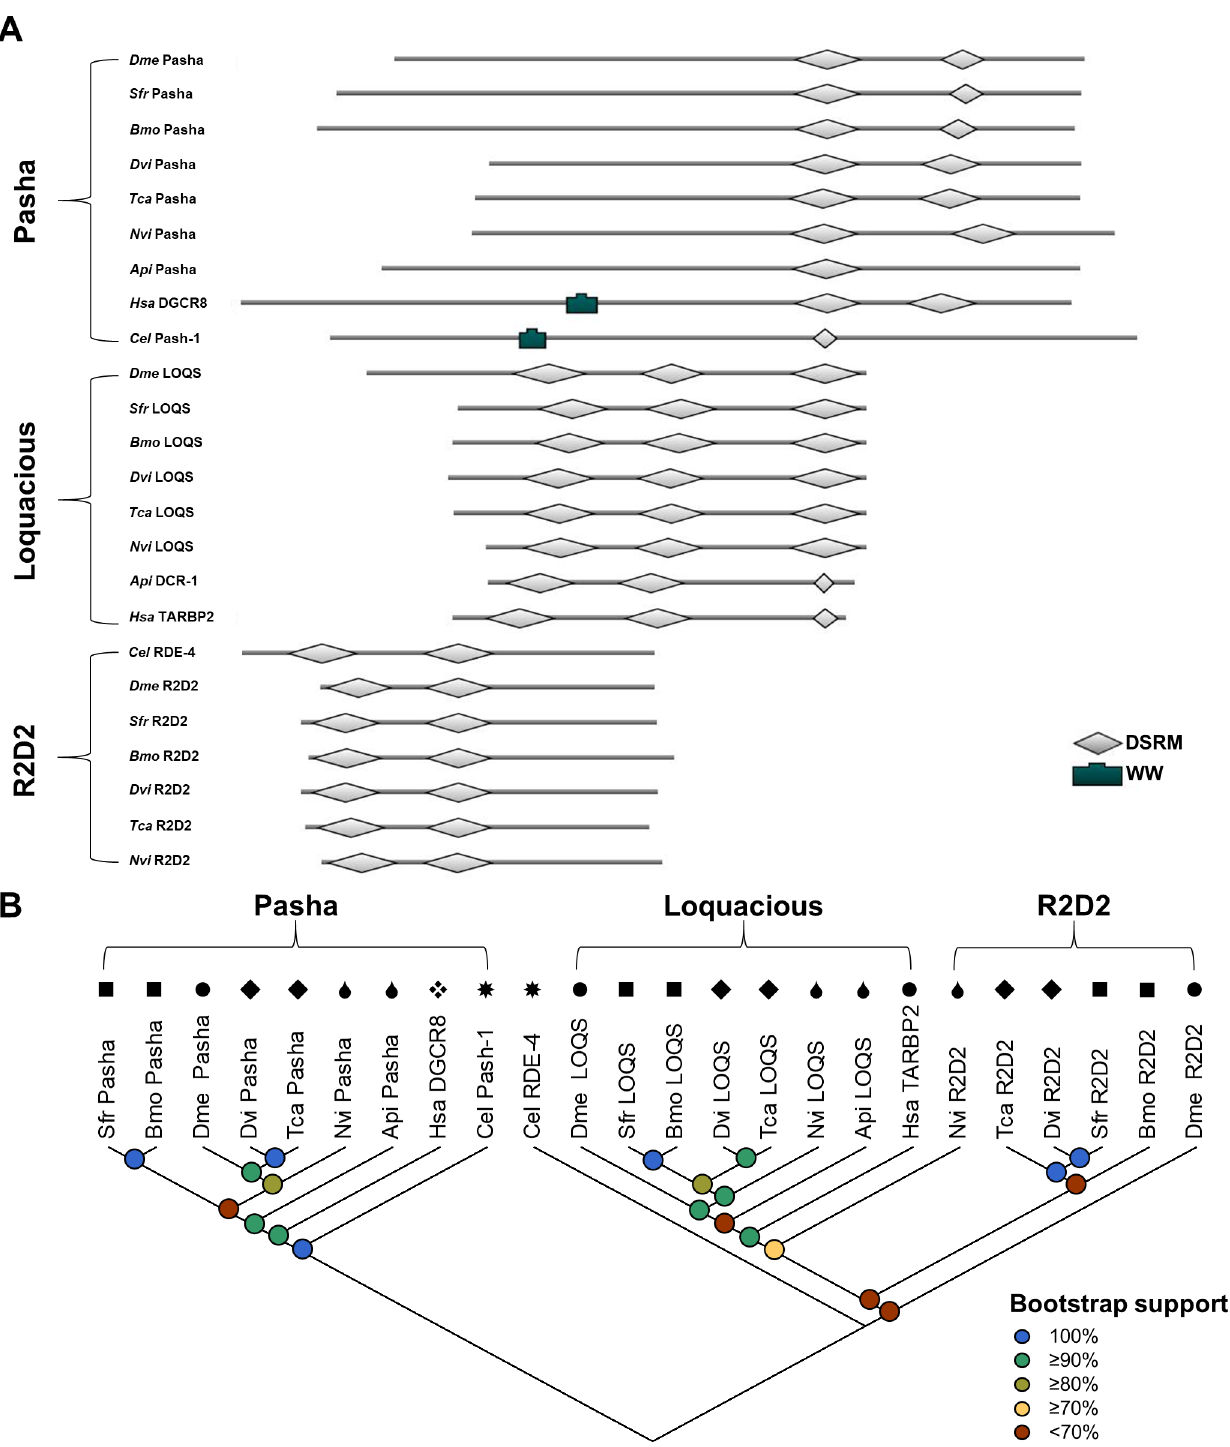
Fig 2. Properties of core mi- and siRNA pathway double-stranded RNA binding proteins in WCR, FAW, and SGSB. (A) The predicted protein domains encoded by the Pasha-PA, LOQS-PB, and R2D2 transcripts of A . pisum (Api: XP_001947403.1, XP_016657757.1), B . mori ( Bmo : XP_012552270.1, XP_012550849.1, NP_001182007.1), C . elegans ( Cel : NP_001293461.1, NP_499265.1), D . melanogaster ( Dme :NP_651879.1, NP_609646.1, NP_609152.1), D . virgifera virgifera (WCR– Dvi :MG225419, MG225420, MG225423), H . sapiens ( Has : NP_073557.3, NP_599150.1), N . viridula (SGSB– Nvi :